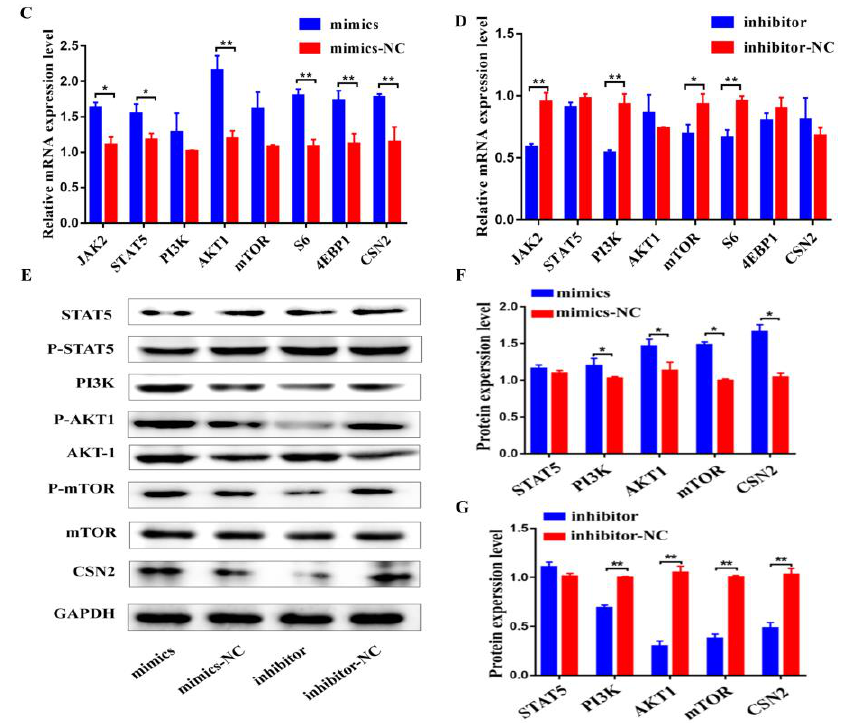
Figure 5. Regulation of Bta-miR-106b on the expressions of genes related to protein and fat synthesis in BMECs. ( A , B ) The mRNA levels of 16 genes involved in fat synthesis at 48 h after transfection with bta-miR-106b mimics and inhibitors in BMECs. ( C , D ) The mRNA levels of 8 genes involved in protein synthesis at 48 h after transfection with bta-miR-106b mimics and inhibitors in BMECs. ( E – G ) Western blot results and the protein expression levels of the genes involved in PI3K/AKT/mTOR pathway in BMECs at 48 h after transfection with bta-miR-106b mimics and inhibitors. (Note: * means p value < 0.05; ** means p value < 0.01.)